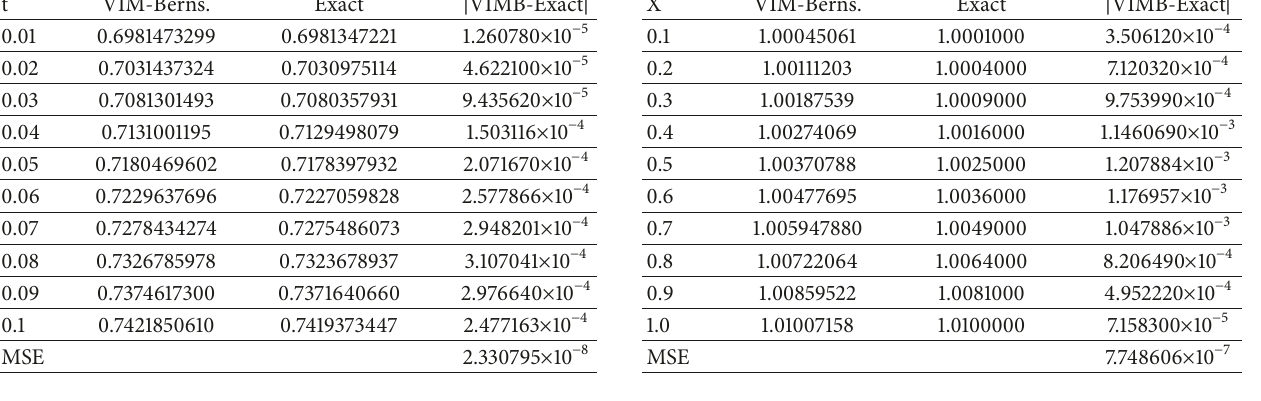
Table 6: The absolute and mean square errors using y 2 for (33) when n=m=3 and 𝑡 = 0.01